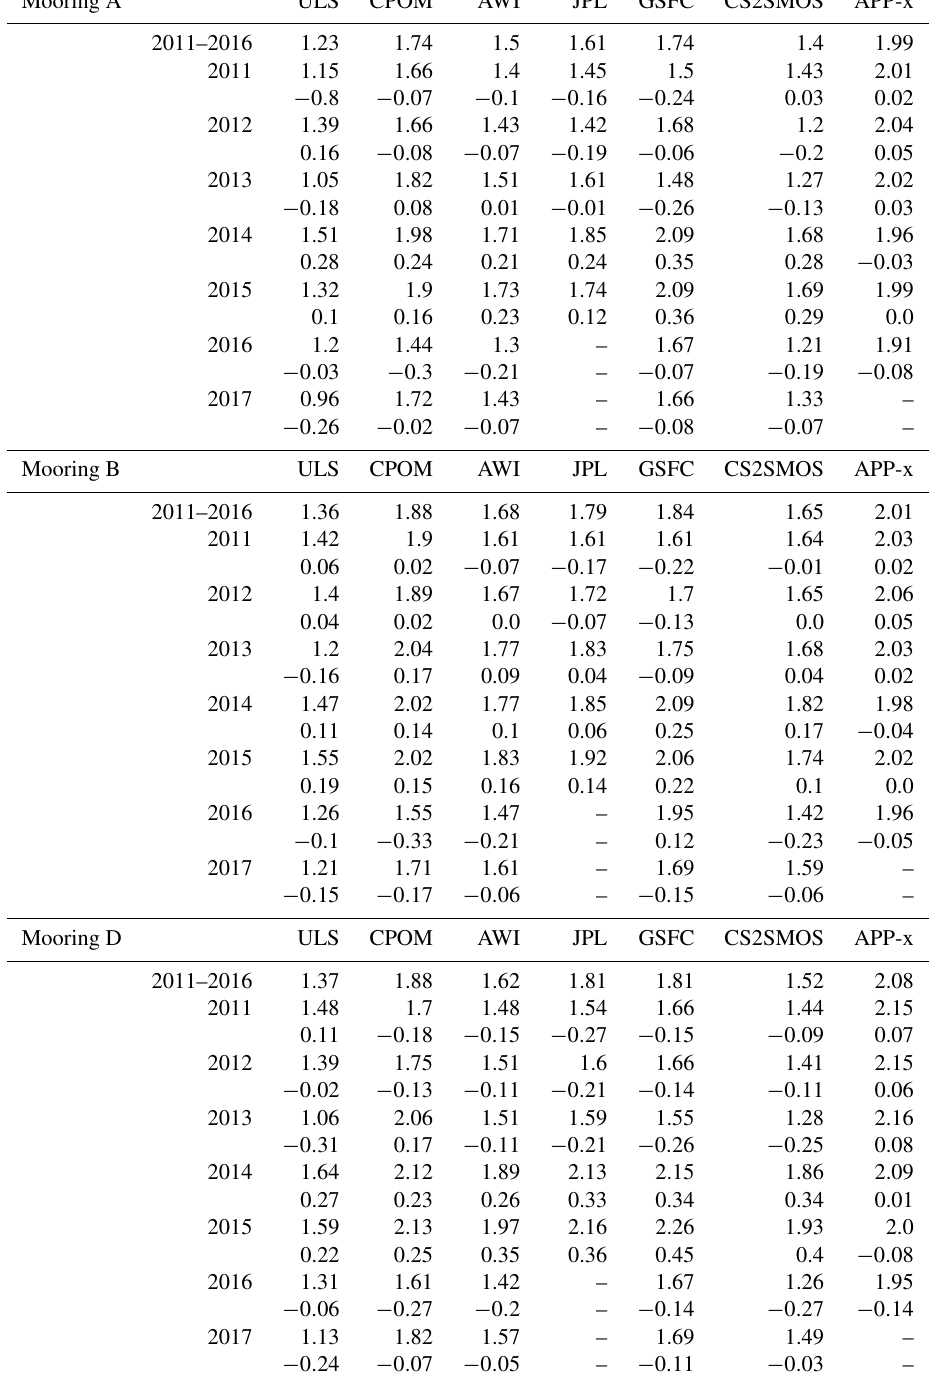
Table 4. Annual winter (January–April ∗ ) sea ice draft–thickness (metres, top value) and deviation from the 2011–2017 mean (metres, bottom value) for each BGEP ULS mooring (A, B, D) and six satellite products (using measurements within 200km of BGEP moorings). Mooring A ULS